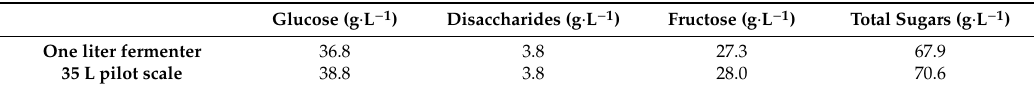
Table 4. Sugar types, content and total sugars (g · L − 1 ) of carob biomass (30% DM) used for LA production after enzymatic hydrolysis using one liter fermenter or 35 L pilot